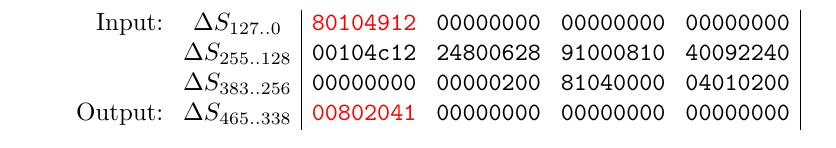
Table 7: Probability 2 − 64 Type 3 differential trail for 338 rounds found with the refined